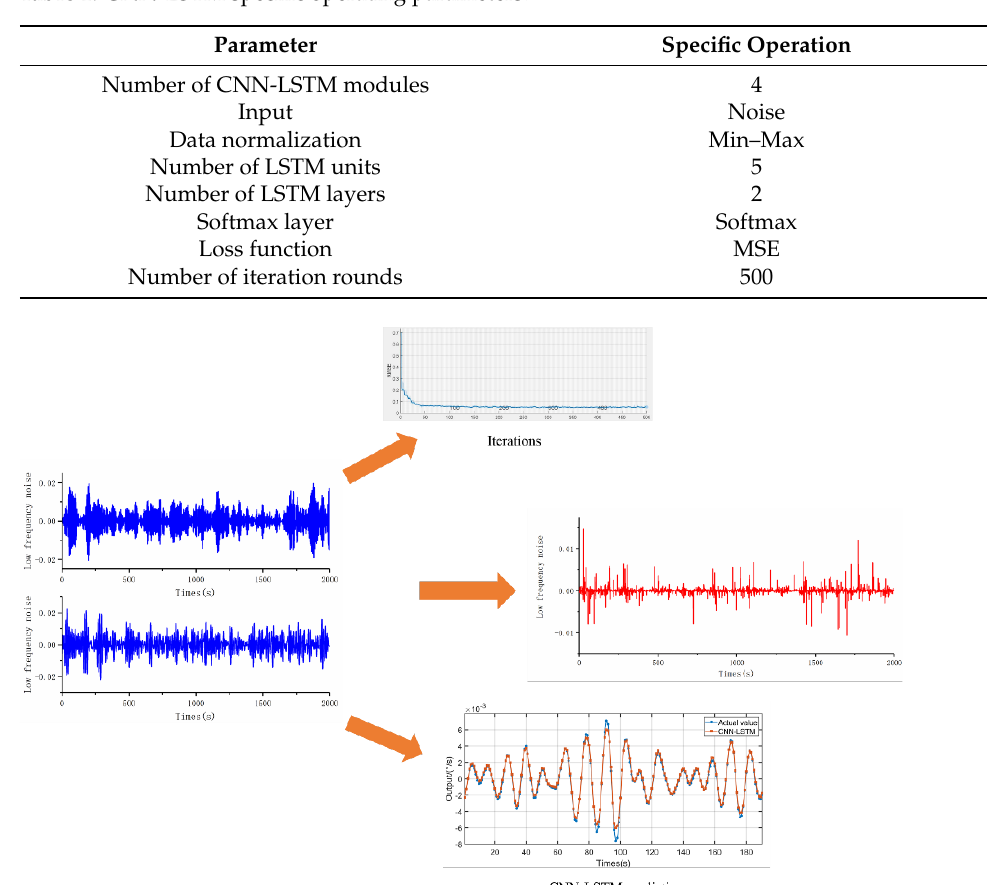
Table 1. CNN-LSTM specific operating parameters.